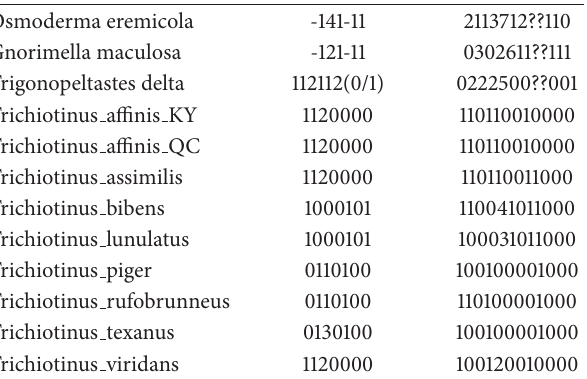
Table 2: List of taxa and their morphological character states used in this study. Note that Trigonopeltastes in character seven is coded as having both states as indicated within the